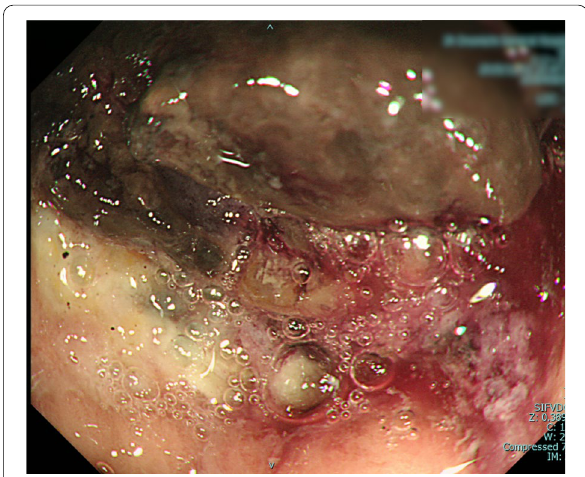
Fig. 2 Upper gastrointestinal endoscopy shows the spontaneous hemostatic ulcer located in the upper posterior wall of the gastric